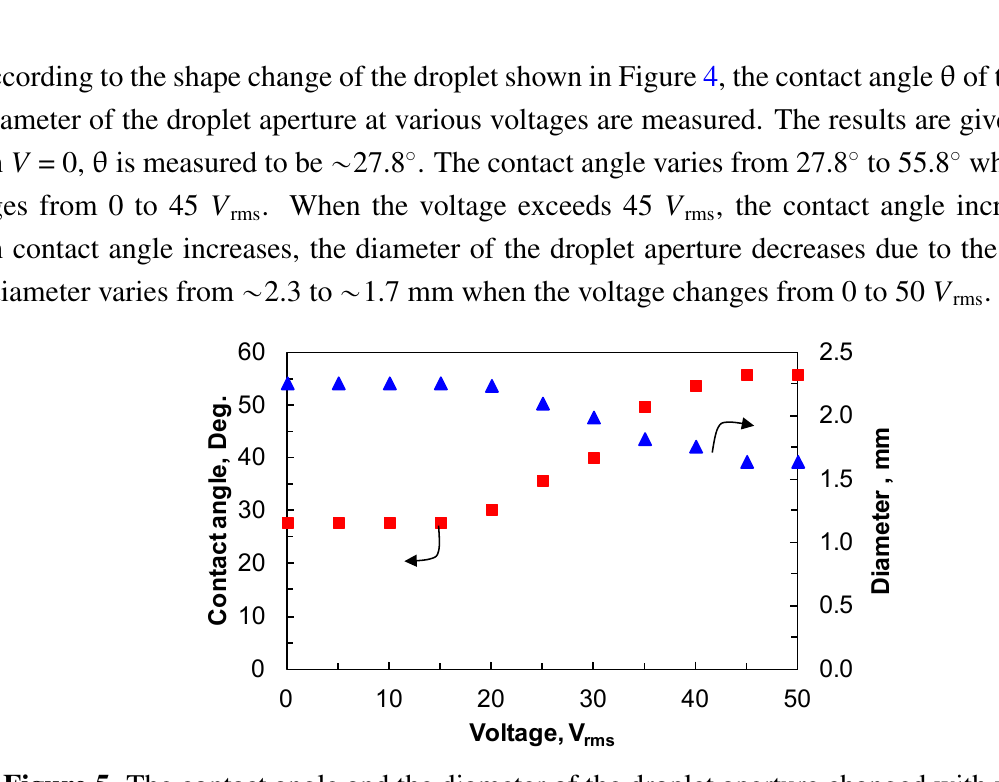
Figure 5. The contact angle and the diameter of the droplet aperture changed with voltages.